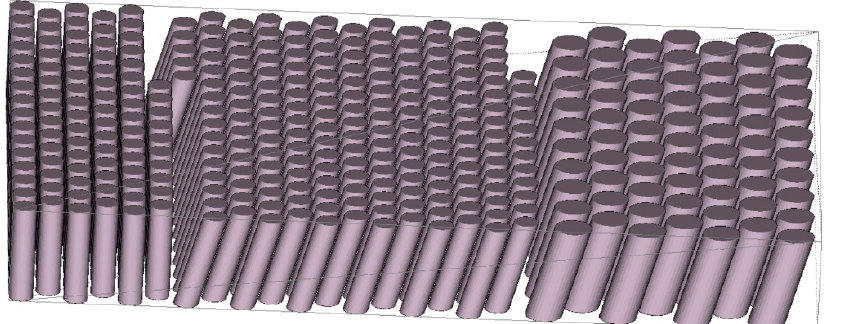
Figure 21. Arrangement of the CGx on BP_1_3-5.